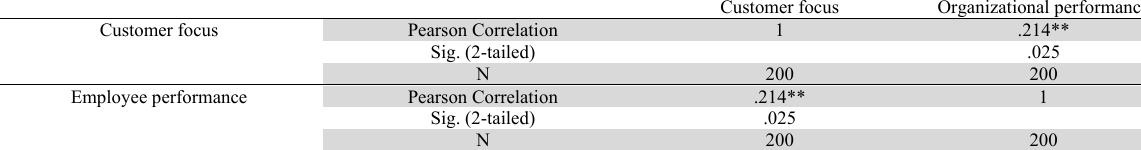
Correlation between customer focus and organizational performance